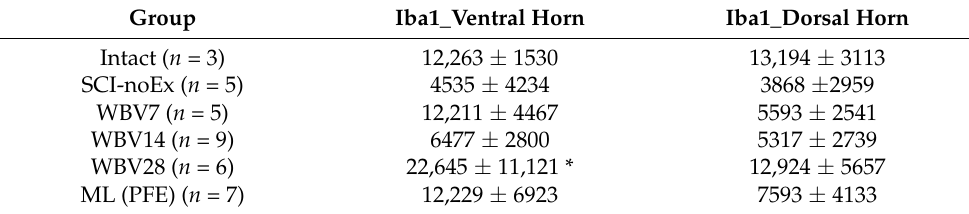
Table 3. Iba1 expression, as defined by absolute pixel number (PN) in the ventral horns and dorsal horns of the lumbar-spinal-cord L2 segments of intact rats and injured, treated, and non-treated rats at 12 weeks after SCI. Groups’ mean values ± SD are shown. The WBV28 therapy led to a significant increase in Iba1 expression in the ventral horn (asterisk; p = 0.028, WBV28 vs. SCI-noEx; p = 0.019, WBV28 vs. WBV14; Kruskal–Wallis, Dunn’s